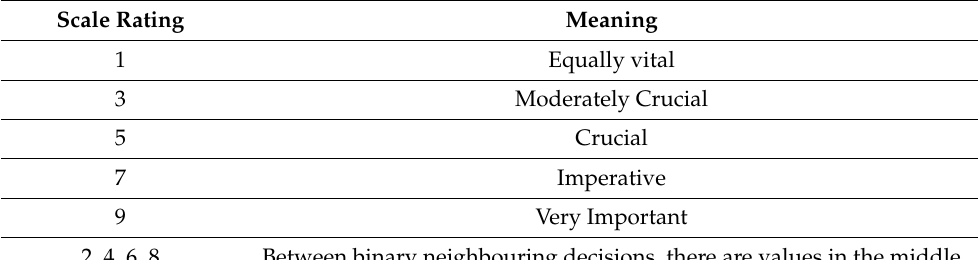
Table 2. Important scale of nine points of intensity. Scale Rating Meaning